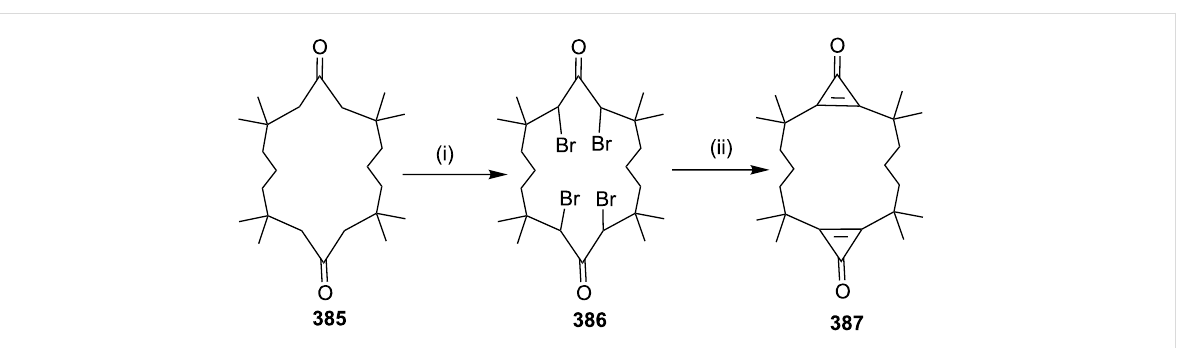
Scheme 70: Synthesis of cyclopropanophane via Favorskii rearrangement. Reagents and conditions: (i) Br 2 , CH 2 Cl 2 , 5 h, rt, 46%; (ii) KO t -Bu, THF, − 40 °C, 30 min,